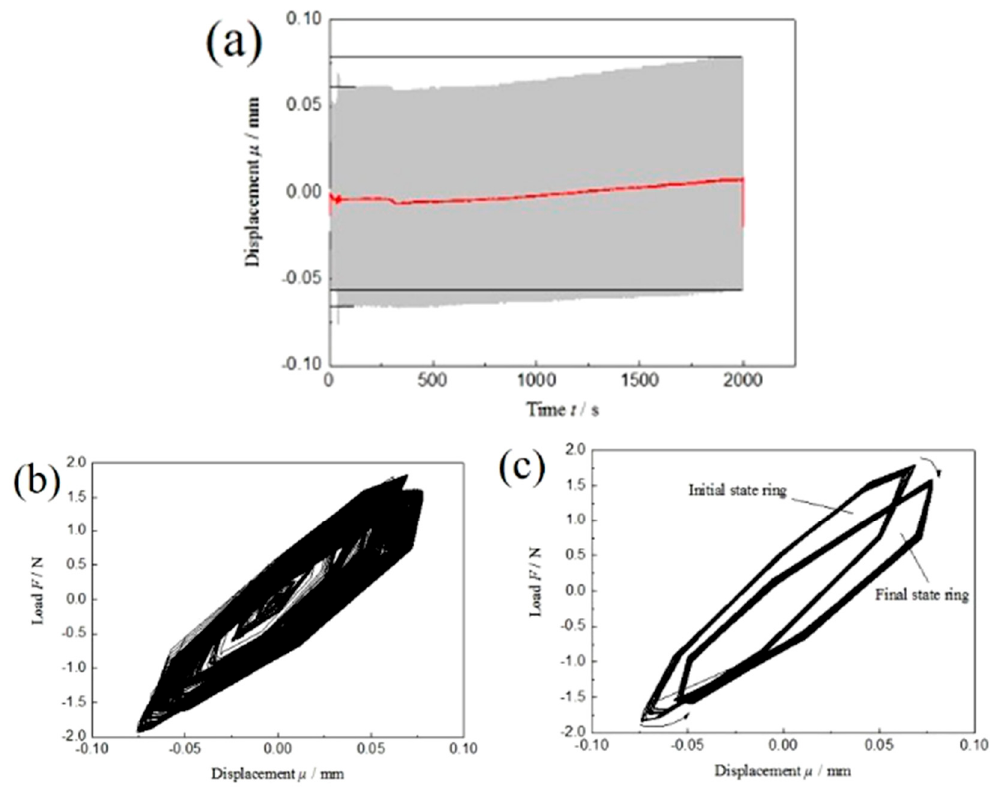
Figure 7. Displacement–time curve ( a ), load–displacement curve ( b ) and migration process of hysteresis loop ( c ) of low-frequency symmetrical fatigue cyclic load of dissimilar Al/steel keyhole-free FSSW joints.